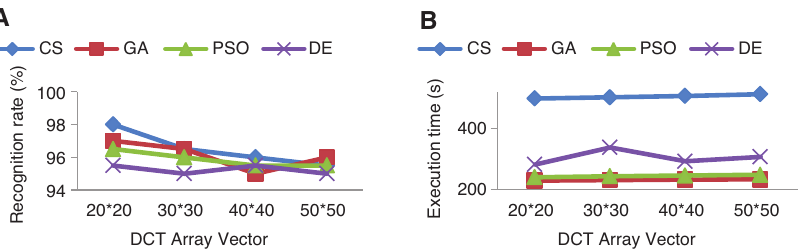
Figure 7: (A) Recognition Rate and (B) Execution Time for Dimensions of Various DCT Feature Vectors for ORL Case